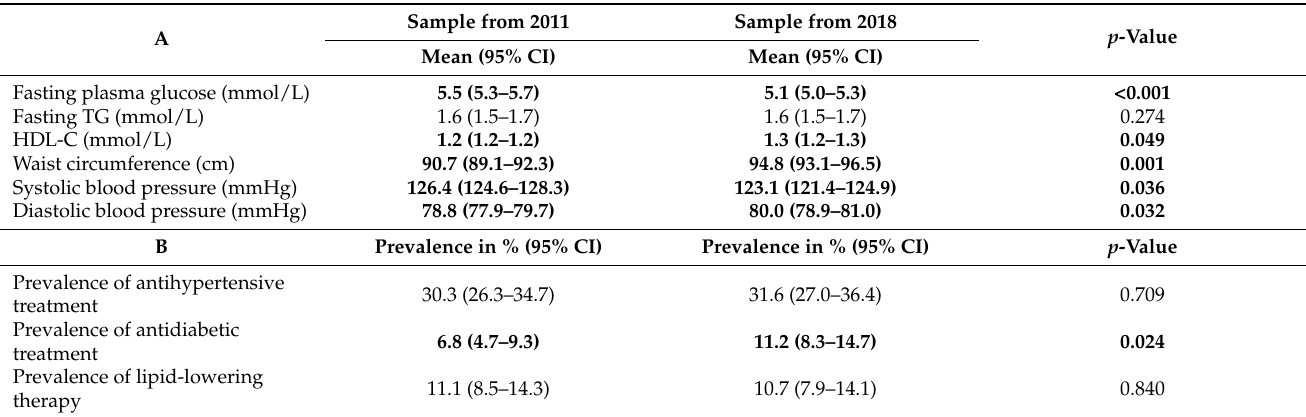
Table 1. Biochemical and physical parameters and the frequency of preventive medication, used to estimate the prevalence of metabolic syndrome in the study